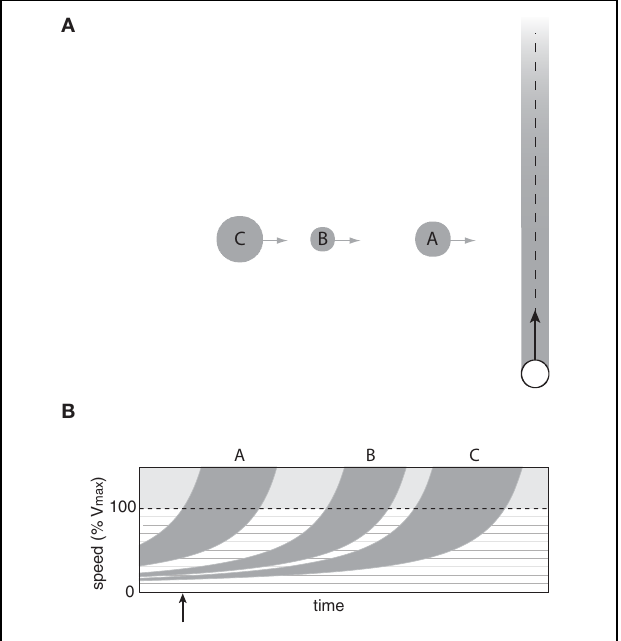
FIGURE 6 | (A) Observer passing through a lane of obstacles on course to cross the observer’s future path. (B) Optically specified range of speeds that would result in a collision with each obstacle as a function of